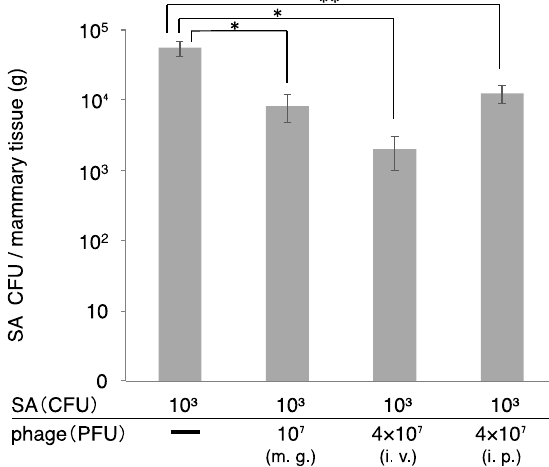
Figure 5. Therapeutic efficacy of Φ SA012 administered intraperitoneally or intravenously in a mouse model of S. aureus mastitis. SA003 (10 3 CFU) was injected into the mammary gland and Φ SA012 was subsequently administrated to the mammary gland (10 7 PFU), intraperitoneal (4 × 10 7 PFU)